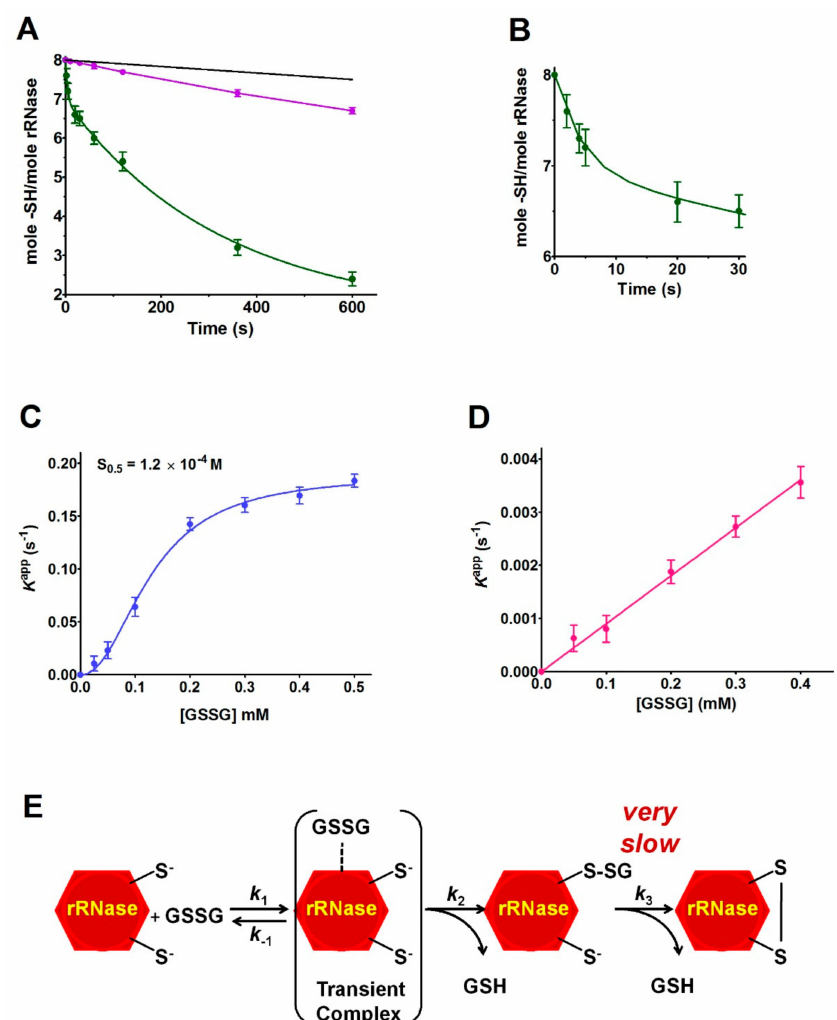
Figure 5. Oxidation of rRNase cysteines by reaction with GSSG. ( A ) The disappearance of rRNase cysteines (1.25 µ M, 10 µ M in –SH groups) during the reaction with 0.4 mM GSSG at pH 7.4, 0.2 M urea at 25 ◦ C (green line). The reaction was followed by determining residual protein sulfhydryls with DTNB (see Materials and Methods). For comparison, the disappearance of the sulfhydryl group of 10 µ M cysteine with 0.4 mM GSSG at pH 7.4, 0.2 M urea at 25 ◦ C is reported (magenta line). Average ± SD from seven independent experiments. Theoretical sulfhydryl groups’ disappearance of an unperturbed protein cysteine (10 µ M) during the reaction with 0.4 mM GSSG (black line) (fit obtained using equation (3)). ( B ) Fast-phase of the reaction between the rRNase and GSSG shown in ( A ). ( C ) Apparent first-order rate constants for the reaction of the rRNase hyper-reactive cysteine with di ff erent GSSG concentrations at pH 7.4, 0.2 M urea at 25 ◦ C. Average ± SD from three independent experiments (fit obtained using equation (4)). ( D ) Apparent first-order rate constants for the remaining five reactive cysteines of the rRNase with di ff erent GSSG concentrations at pH 7.4, 0.2 M urea at 25 ◦ C. Average ± SD from three independent experiments. ( E ) Representative scheme of the reaction of the rRNase with stoichiometric